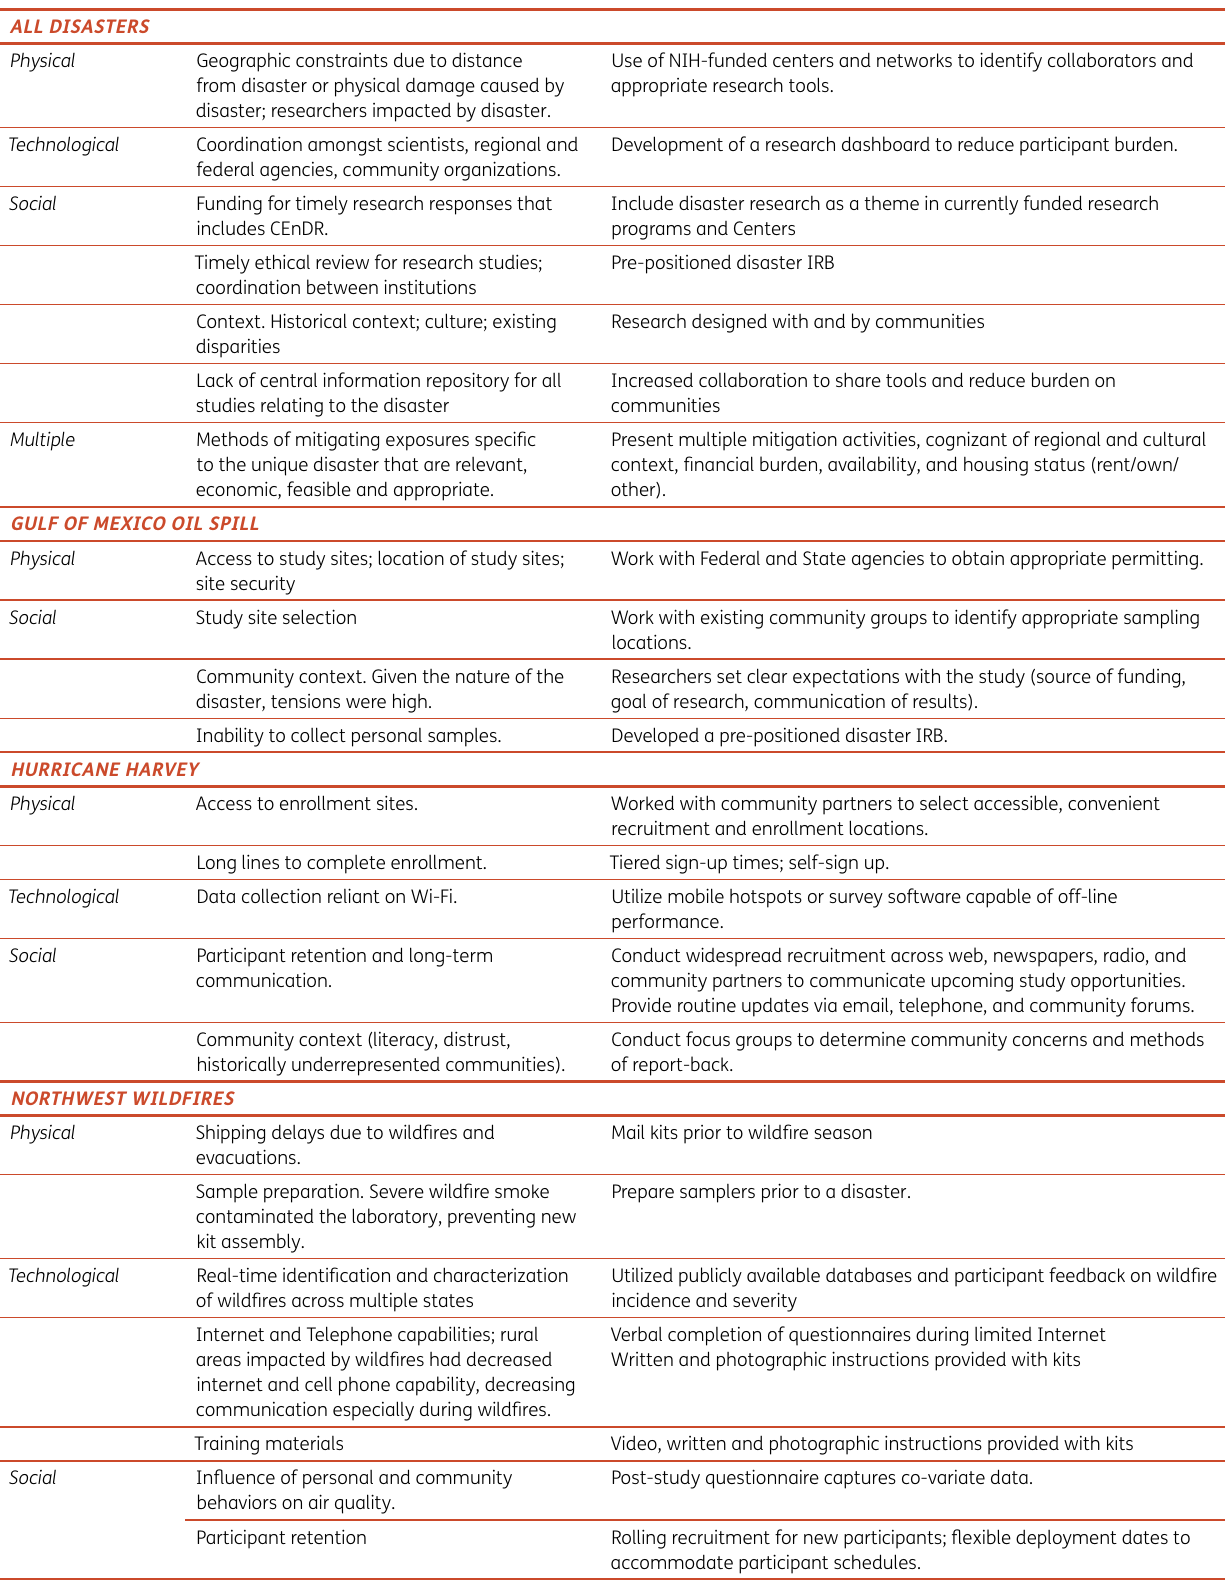
Table 2 Challenges and mitigations associated with community-engaged disaster research